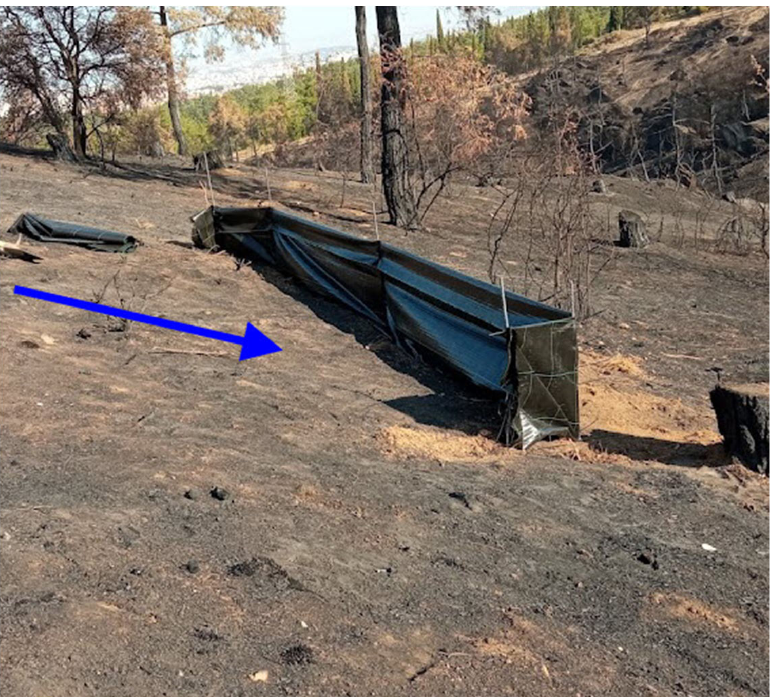
Figure 4. Silt fence installation process: the silt fence was fastened on 5 metal rebars. The blue arrow indicates the runoff direction.